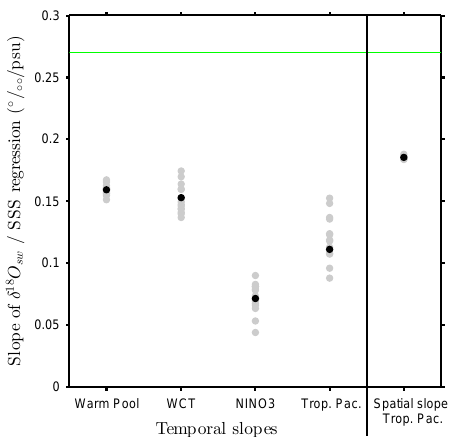
Fig. 8. Values of the δ 18 O sw - SSS temporal regression slopes calculated using the spatial averages over the Warm Pool, Western Cold Tongue (WCT) and NINO3 boxes, as well as the entirety of the tropical Pacific domain (defined as 30 ◦ S to 30 ◦ N and 120 ◦ E to 70 ◦ W), using both the entire 750 yr of model simulation data (black dots) and also this same data split into fifteen non-overlapping 50 yr intervals (grey dots). Also shown is the spatial regression slope calculated using the means (calculated over either the entire simulation or the 50 yr chunks) of the two variables over all the model grid squares within the tropical Pacific domain. The locations of the box regions are shown on Figs. 2, 4. The green reference line shows the 0.27 ‰ psu − 1 value for the spatial tropical Pacific slope derived from instrumental data in LeGrande and Schmidt (2006).